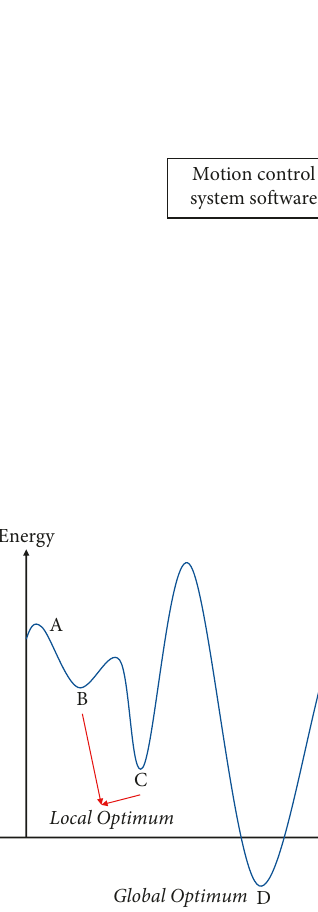
Figure 5: Principle of the simulated annealing algorithm.